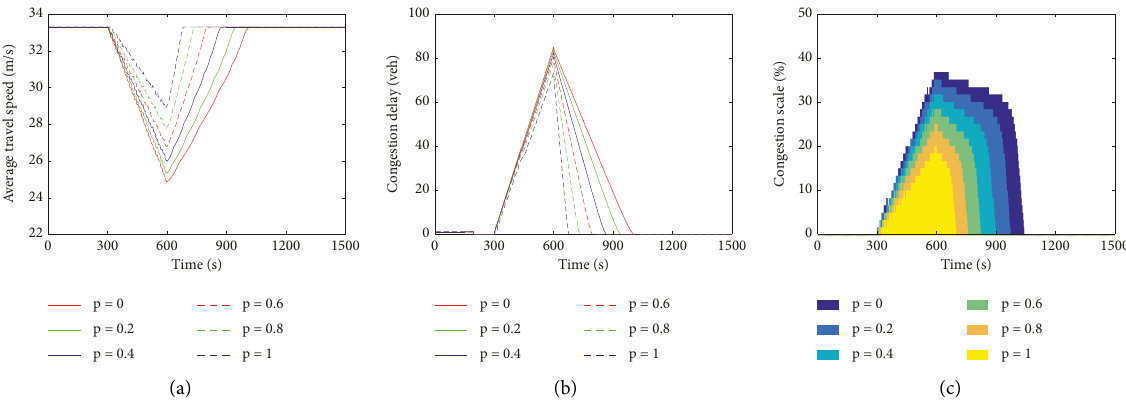
Figure 9: Traffic congestion assessment results under different CAV penetration rates: (a) average travel speed, (b) congestion delay, and (c) congestion